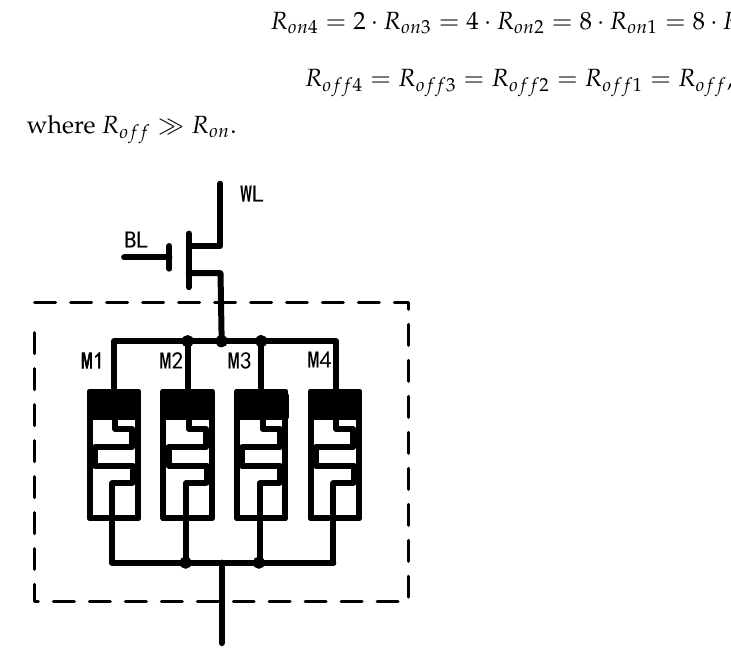
Figure 2. A 1T4M memory